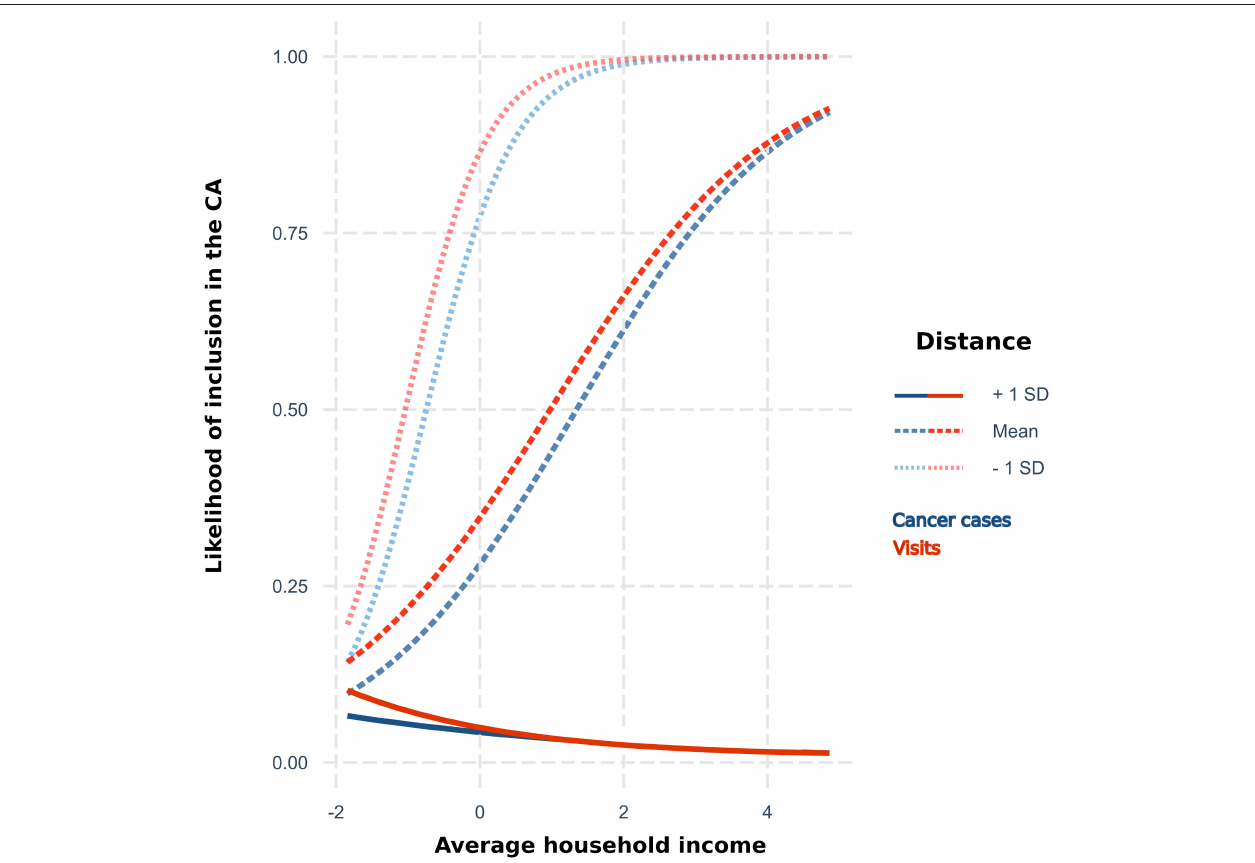
FIGURE 3 | Likelihood of inclusion in the proposed catchment area by average household income [centered to the mean ($ 77,571)] for three levels of distance (centered, mean = 125.6km) to the hospital according to the results of the logistic regression for cancer cases and